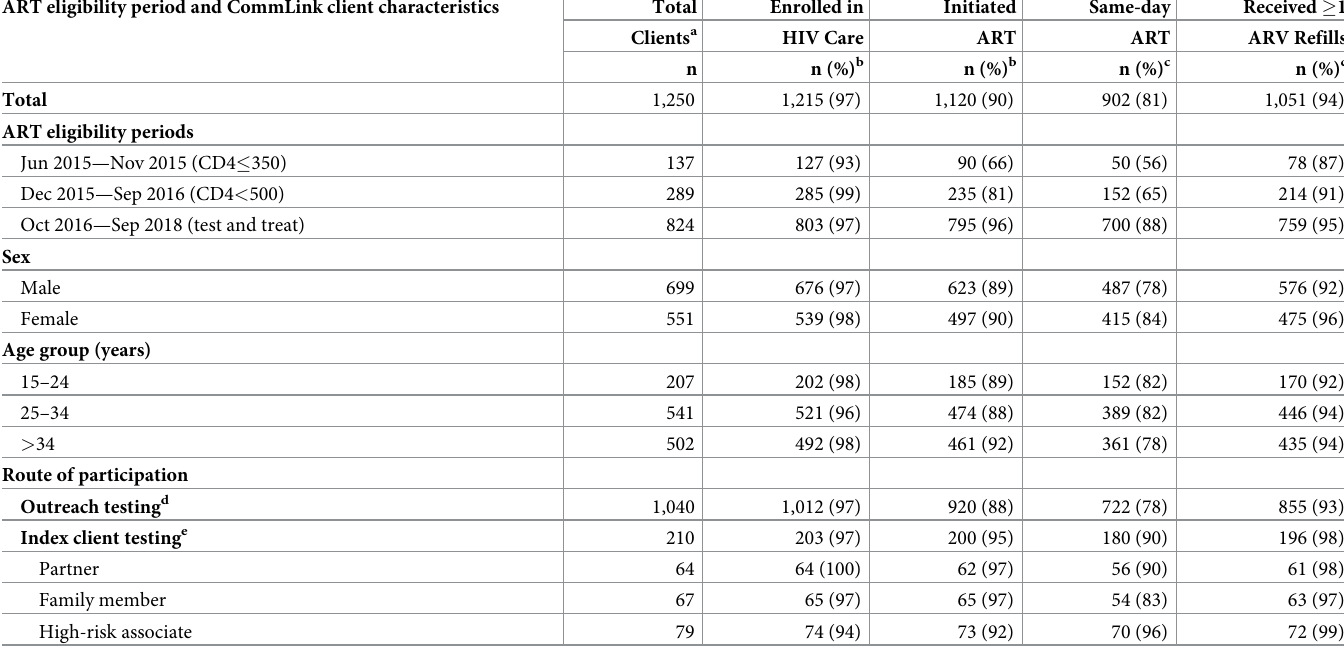
Table 4. Enrollment in facility-based HIV care, ART initiation, and antiretroviral refill outcomes, by ART-eligibility period, CommLink client characteristics, and route of participation, Eswatini, June 2015 –September 2018. ART eligibility period and CommLink client